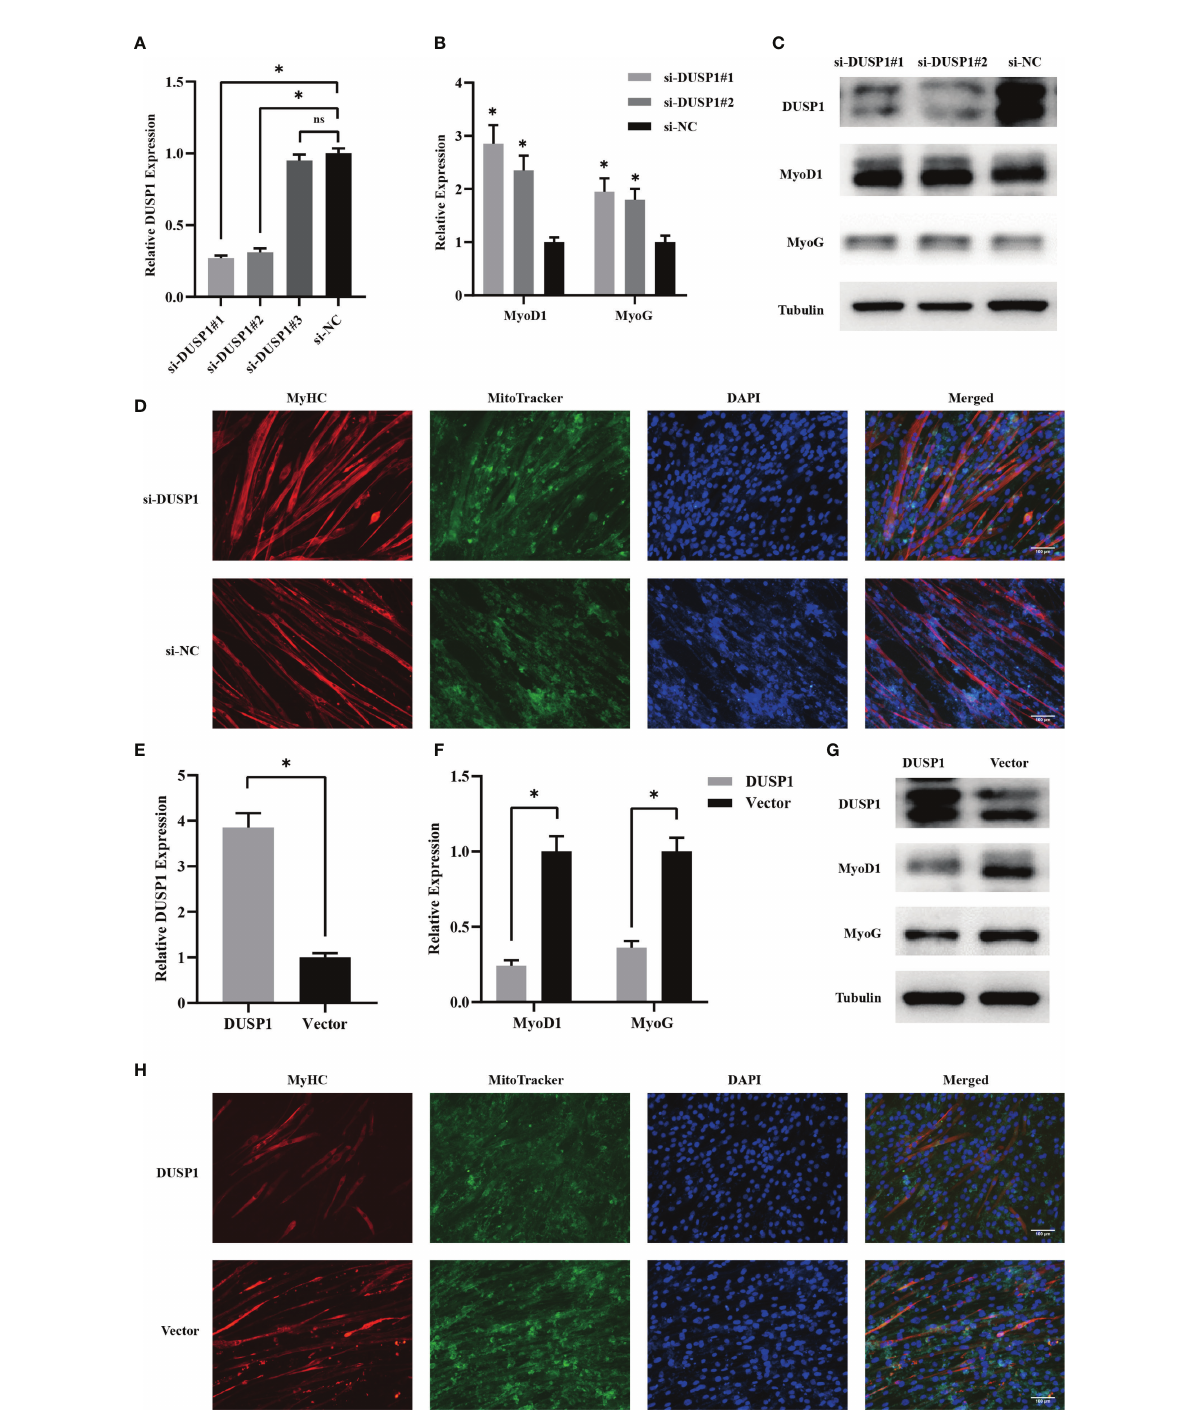
FIGURE 6 DUSP1suppressed myoblastdifferentiation invitro . (A) RelativeDUSP1expressionwithorwithoutDUSP1knockdown. (B,C) Expressionofmarkersin myocytewithoutorwithknockdownofDUSP1by qPCR andWesternblotanalysis. (D) Representativeimagesof theC2C12myotubewithout/with knockdownofDUSP1. Myotube wasstainedwithMyHCandMitoTracker. (Scale bar=100 m m). (E) RelativeDUSP1expressionwithorwithoutDUSP1 overexpression. (F,G) Expressionof markersinmyocytewithoutorwithoverexpressionof DUSP1by qPCRand Westernblotanalysis. (H) Representative imagesof theC2C12myotubewithout/withoverexpressionofDUSP1. Myotube wasstainedwithMyHCandMitoTracker. *p <0.05;ns, notsigni fi